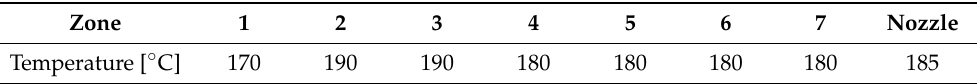
Table 2. Temperature setting along cylinder of double screw extruder.